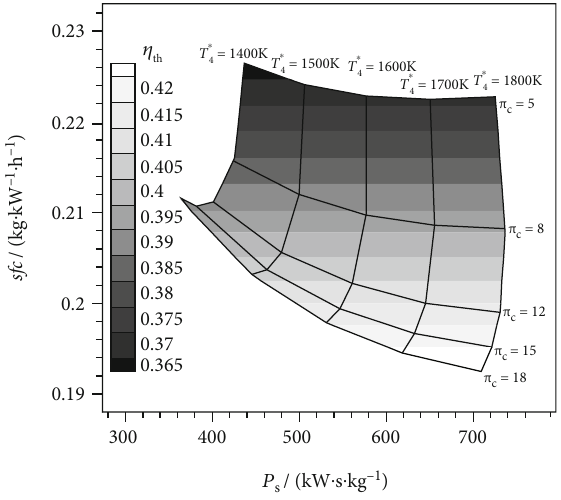
Figure 4: Variations in performance metrics with cycle parameters under high altitude cruise condition.